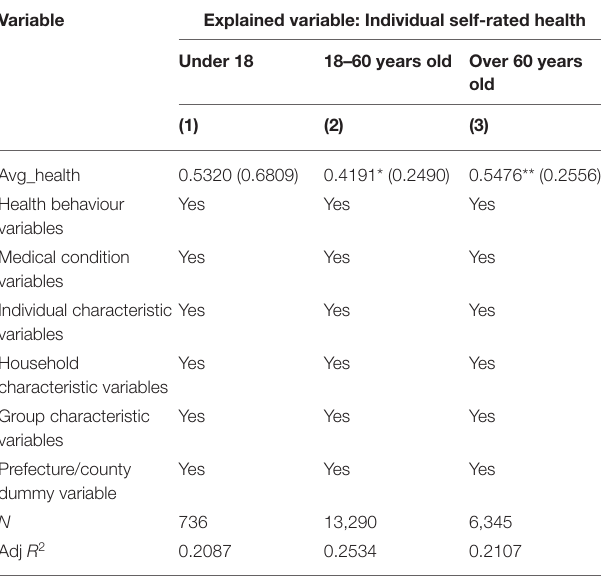
TABLE 9 | Test results for the learning or imitation mechanism of health